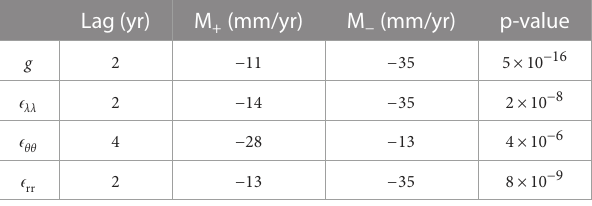
TABLE1 Lag(yr)betweentheelevationrateandthegravitychangesand strainchanges,mediansoftheelevationrateinthepositive ( M + ) and negative ( M − ) phases,andtheassociatedWilcoxontest p